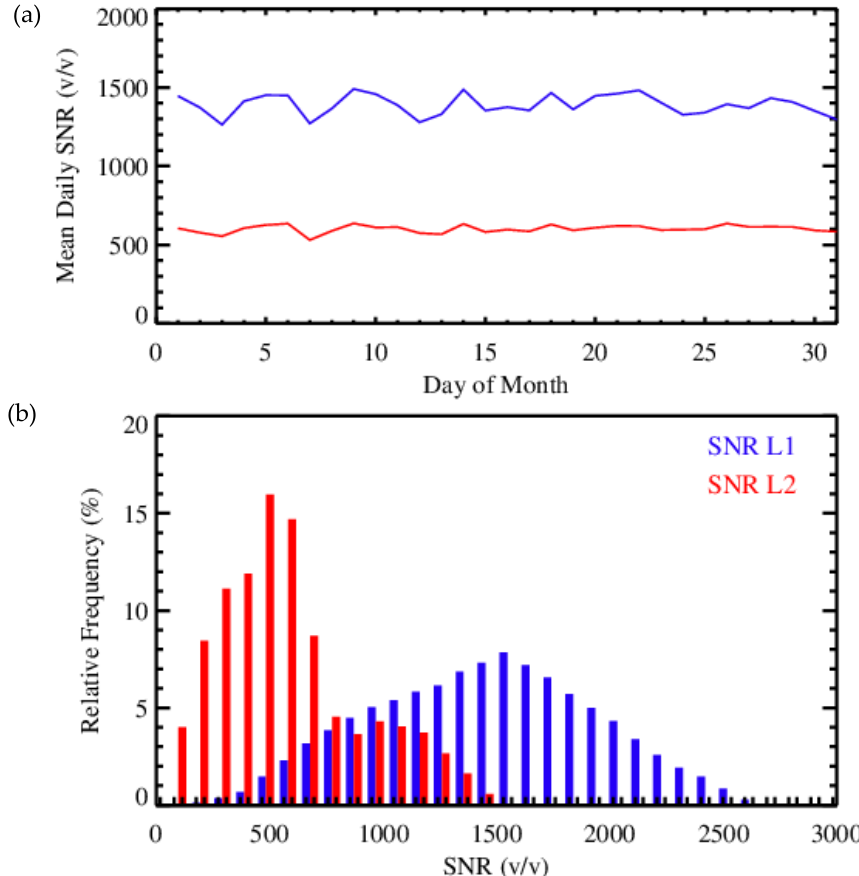
Figure 10. COSMIC-2 SNR characteristics: ( a ) the daily average SNR and ( b ) frequency distribution of SNR for October